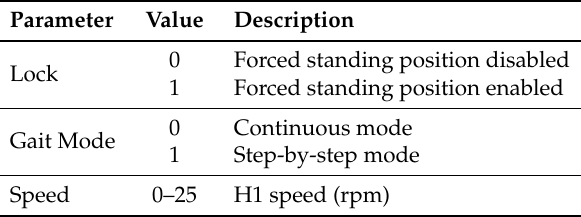
Table 3. H1 configuration frame parameters.